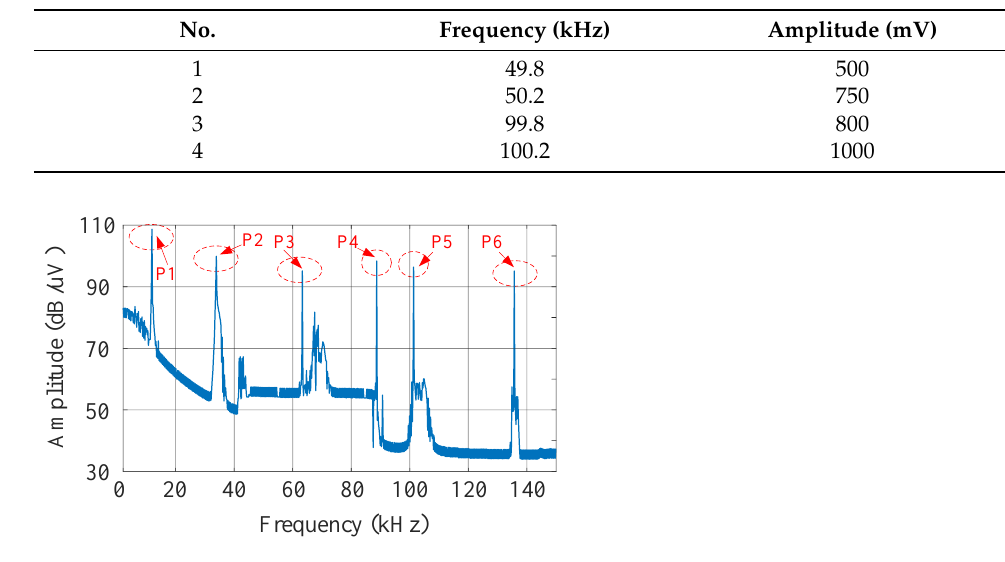
Figure 1. Class D test signal spectrum. Table 2. Class D test signal main emission